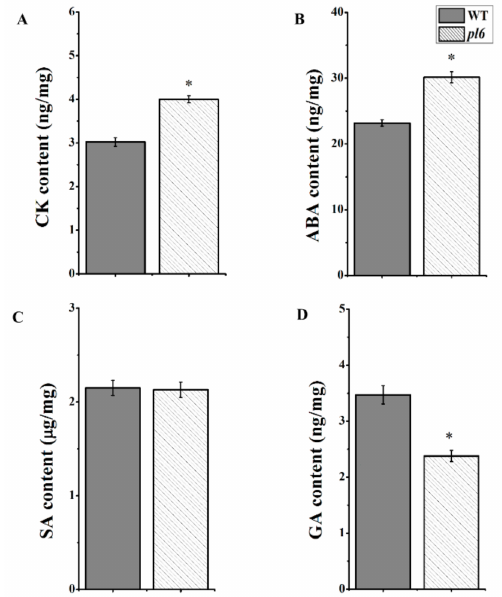
Figure 8. Detection of various phytohormones of the WT and the pl6 mutant. Cytokanin (CK) ( A ), abscisic acid (ABA) ( B ), salicylic acid (SA) ( C ) and gibberellic acid (GA) ( D ) content of the top of flag leaves at the late tillering stage. All values are the mean ± SD of three biological replications. * p < 0.05 by Tukey’s test.